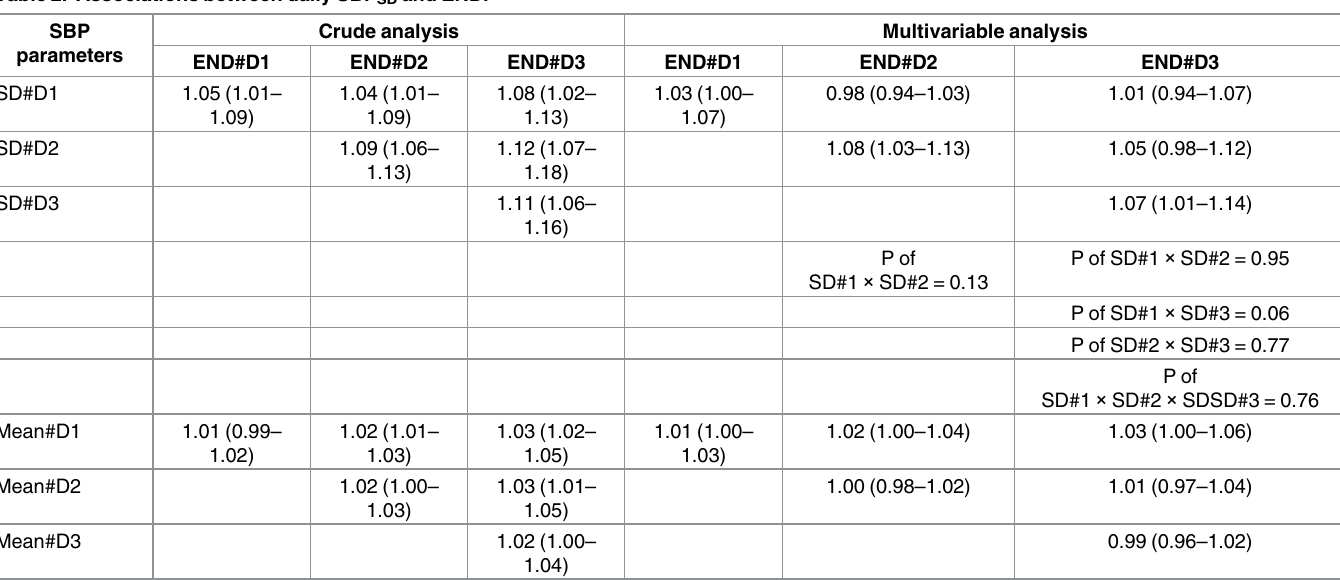
Table 2. Associations between daily SBP SD and